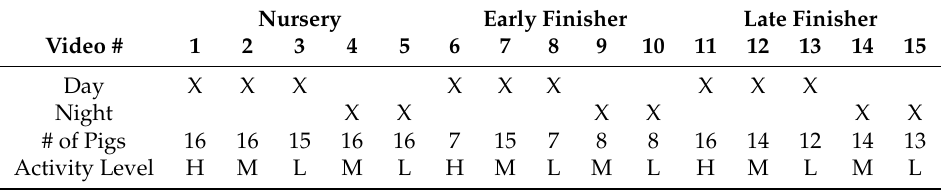
Table 1. Properties of the fifteen videos captured and annotated for tracking performance analysis. For each age range (nursery, early finisher, and late finisher), three videos were captured during the day with the lights on and two videos were captured at night using IR video capture and IR flood lights to illuminate the scene. The activity levels for the pigs were subjectively categorized as either High (H), Medium (M), or Low (L). Nursery Early Finisher Late Finisher Video #